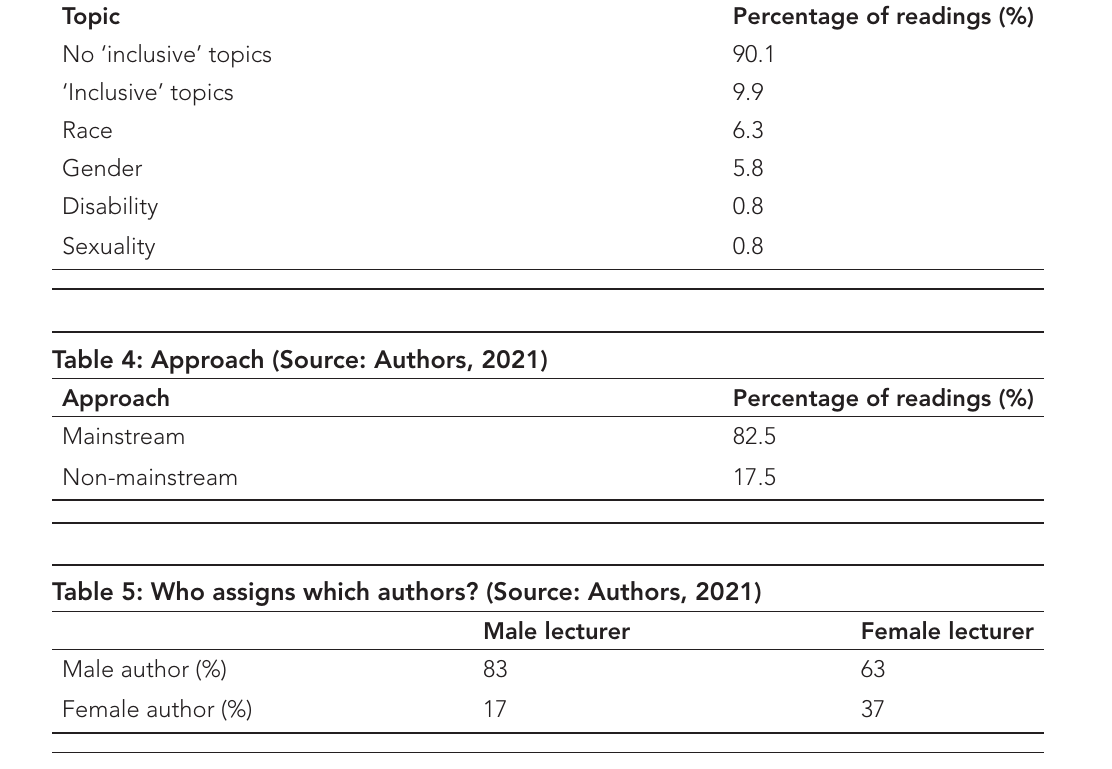
Table 3: Topics (Source: Authors, 2021)